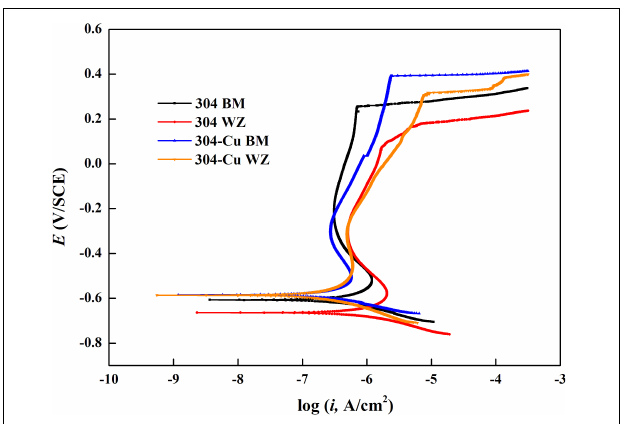
FIGURE 9 | Potentiodynamic polarization curves of various 304L SS electrodes after 14 days of immersion in the 2216E culture medium with Pseudomonas aeruginosa . SS, stainless